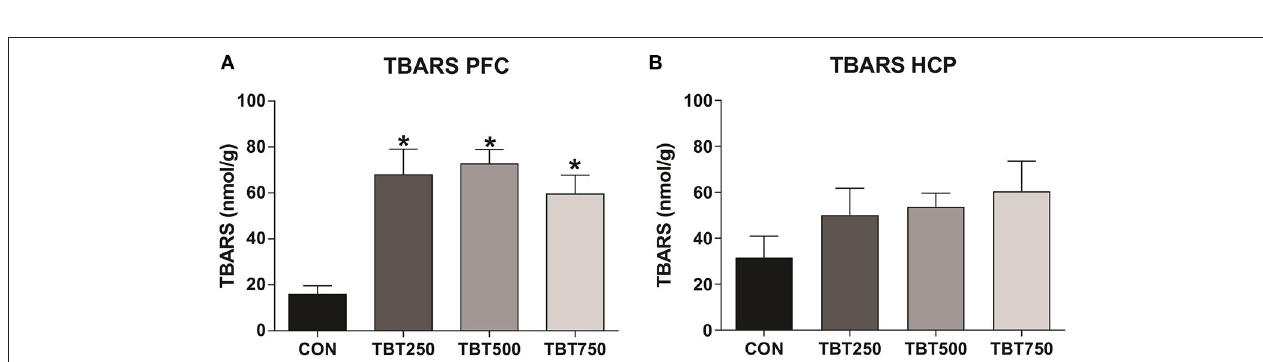
FIGURE 2 | TBT exposure induced abnormal ER α protein expression in brain areas of female mice. Reduced ER α protein expression in the PFC (A) and hippocampus (HCP) (B) from female mice. * p < 0.05 vs. CON; ** p < 0.01 vs. CON; # p < 0.05 vs. TBT750 (one-way ANOVA, followed by Bonferroni’s test).